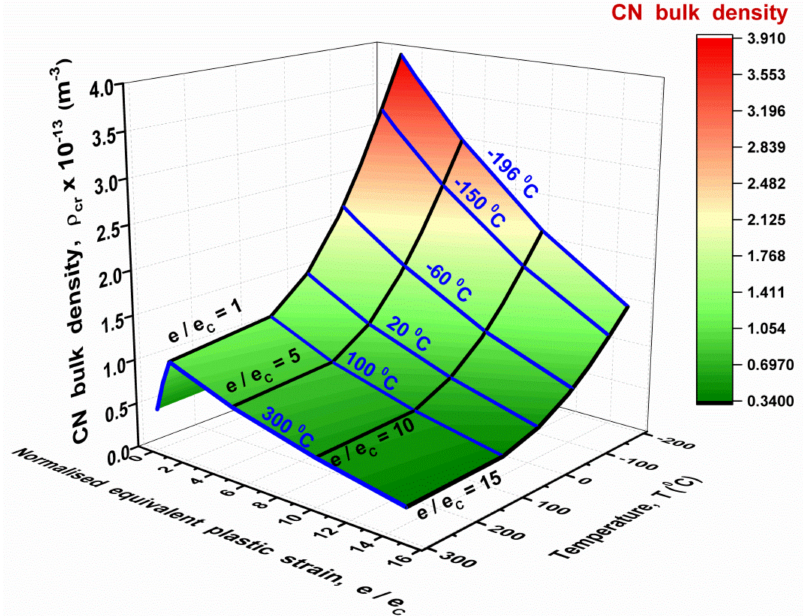
Figure 1. (Colour online). The effect of temperature T and plastic strain value e on the CN density ρ for the RPV steel: e is the equivalent plastic strain; e C is the critical value of strain ( e C =